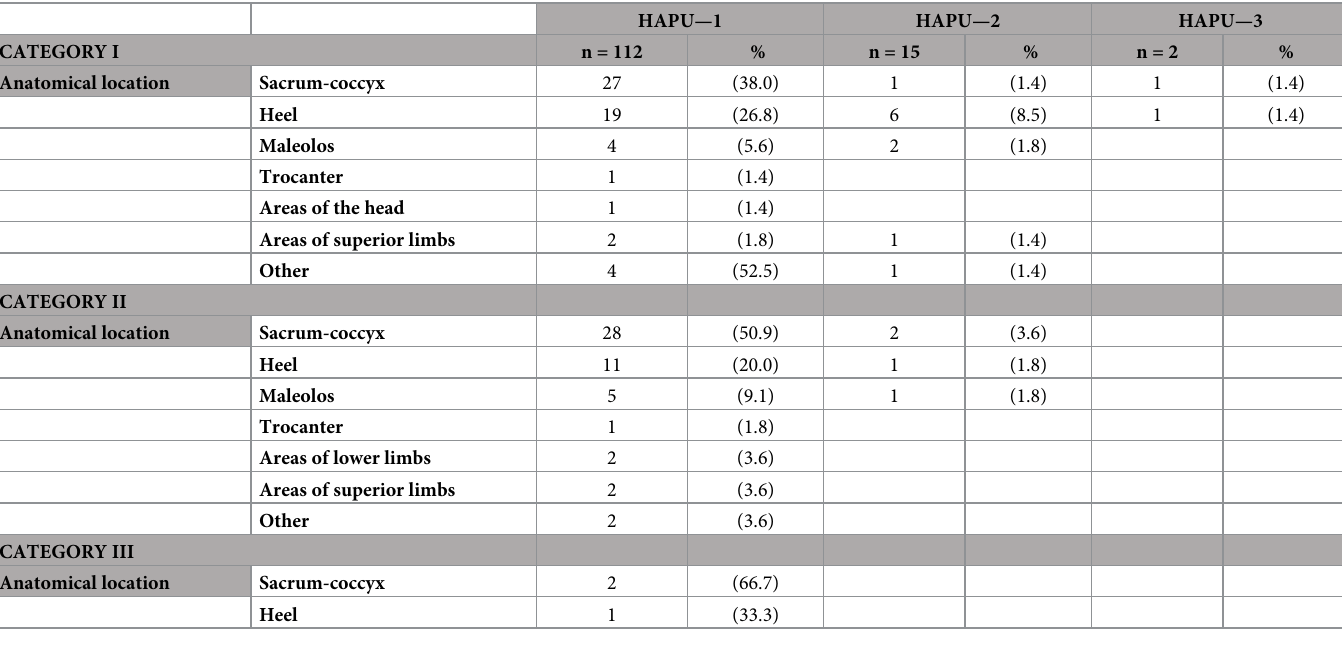
Table 4. Detailed description of HAPU by category and anatomical